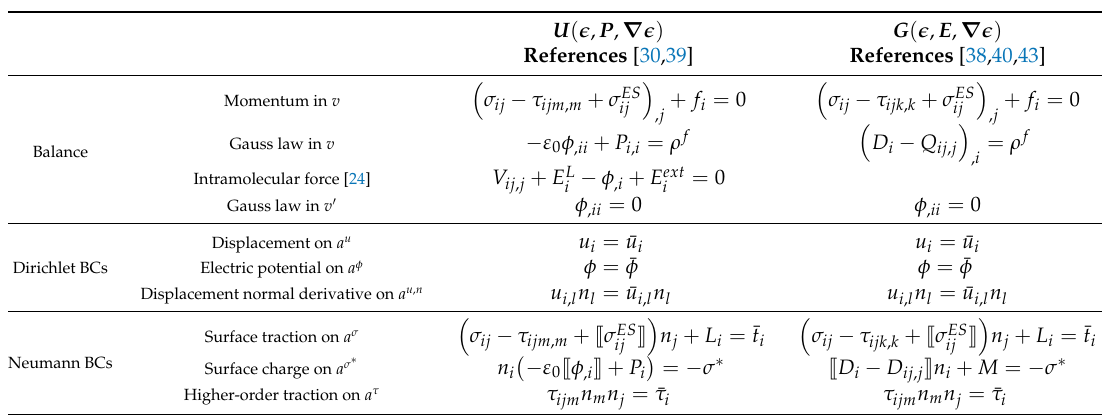
Comparison of reduced strong